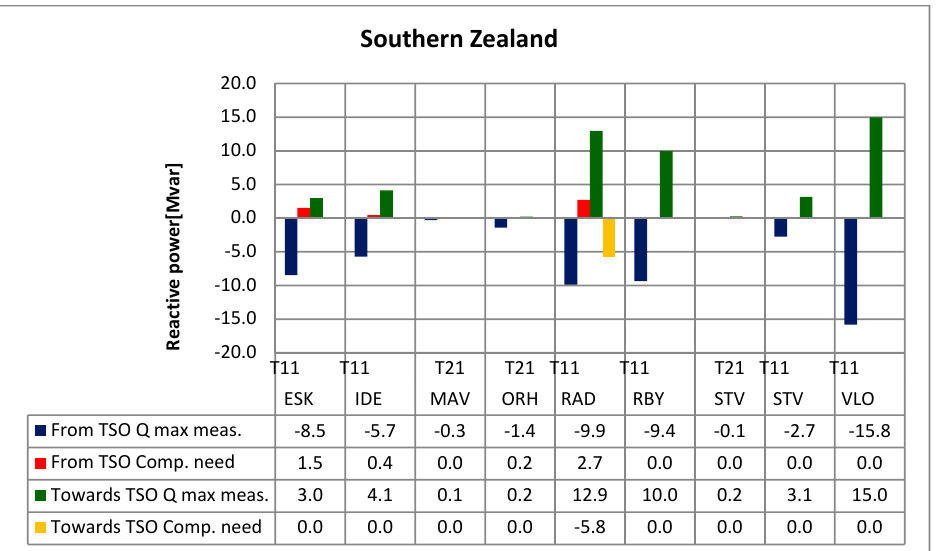
Figure 5. Scatter plot for transformer at station RAD where 1 − 99% fraction data is used. The red rectangle indicates acceptable limits for the transfer of power.